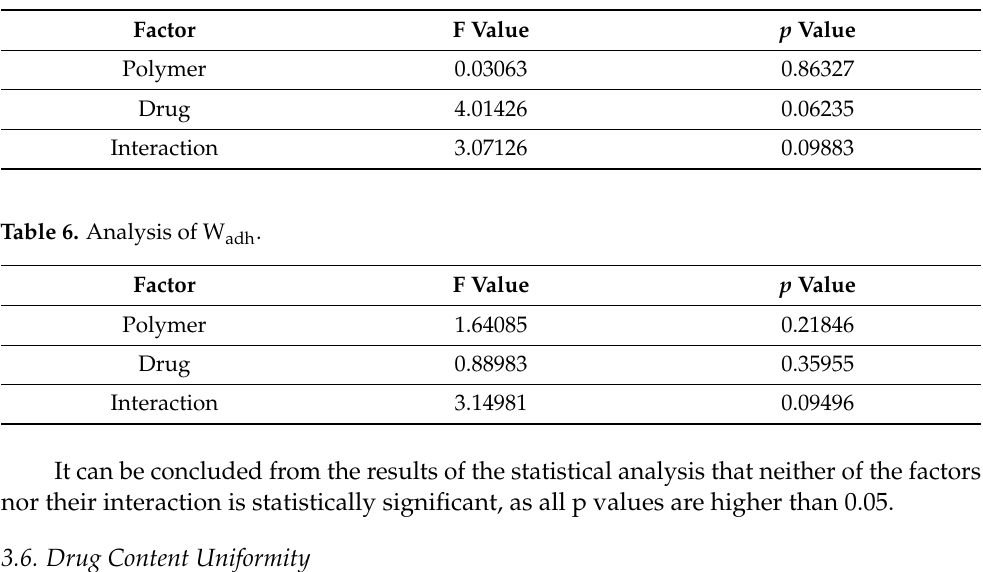
Table 5. Analysis of F adh .